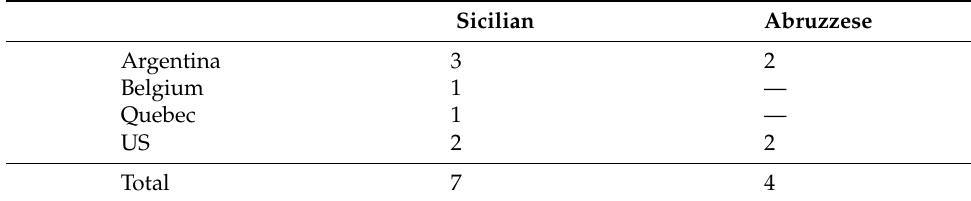
Table 2. Participants.